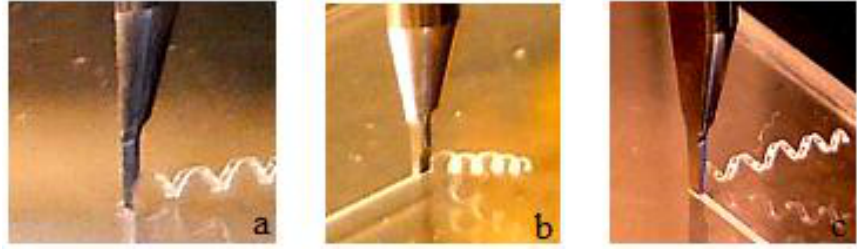
Figure 7. Details of the fabrication process. ( a ) A rear view of the fabrication process; ( b ) A right view of the fabrication process; ( c ) A left view of the fabrication